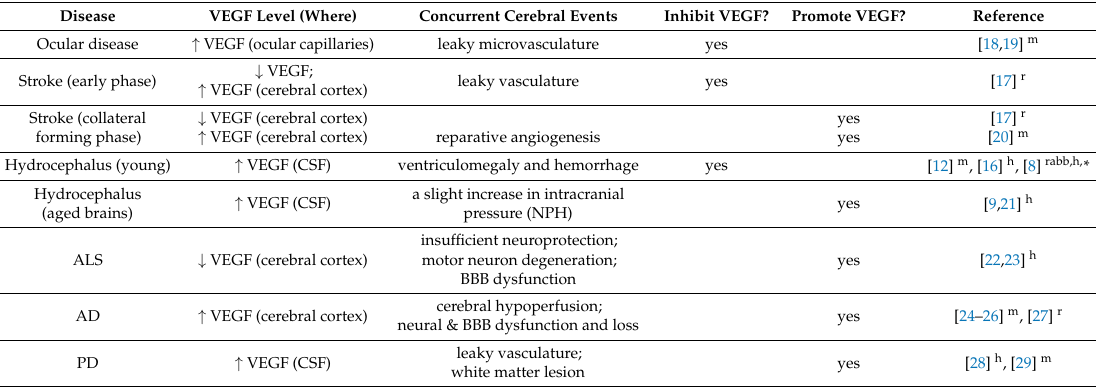
Table 1. Vascular endothelial growth factor (VEGF) signaling in neurological